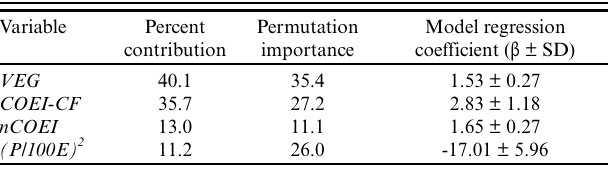
Table 5 . Best supported variables in the cross-category analysis of Avian Cholera outbreak probability predictors at Common Eider ( Somateria mollissima ) breeding